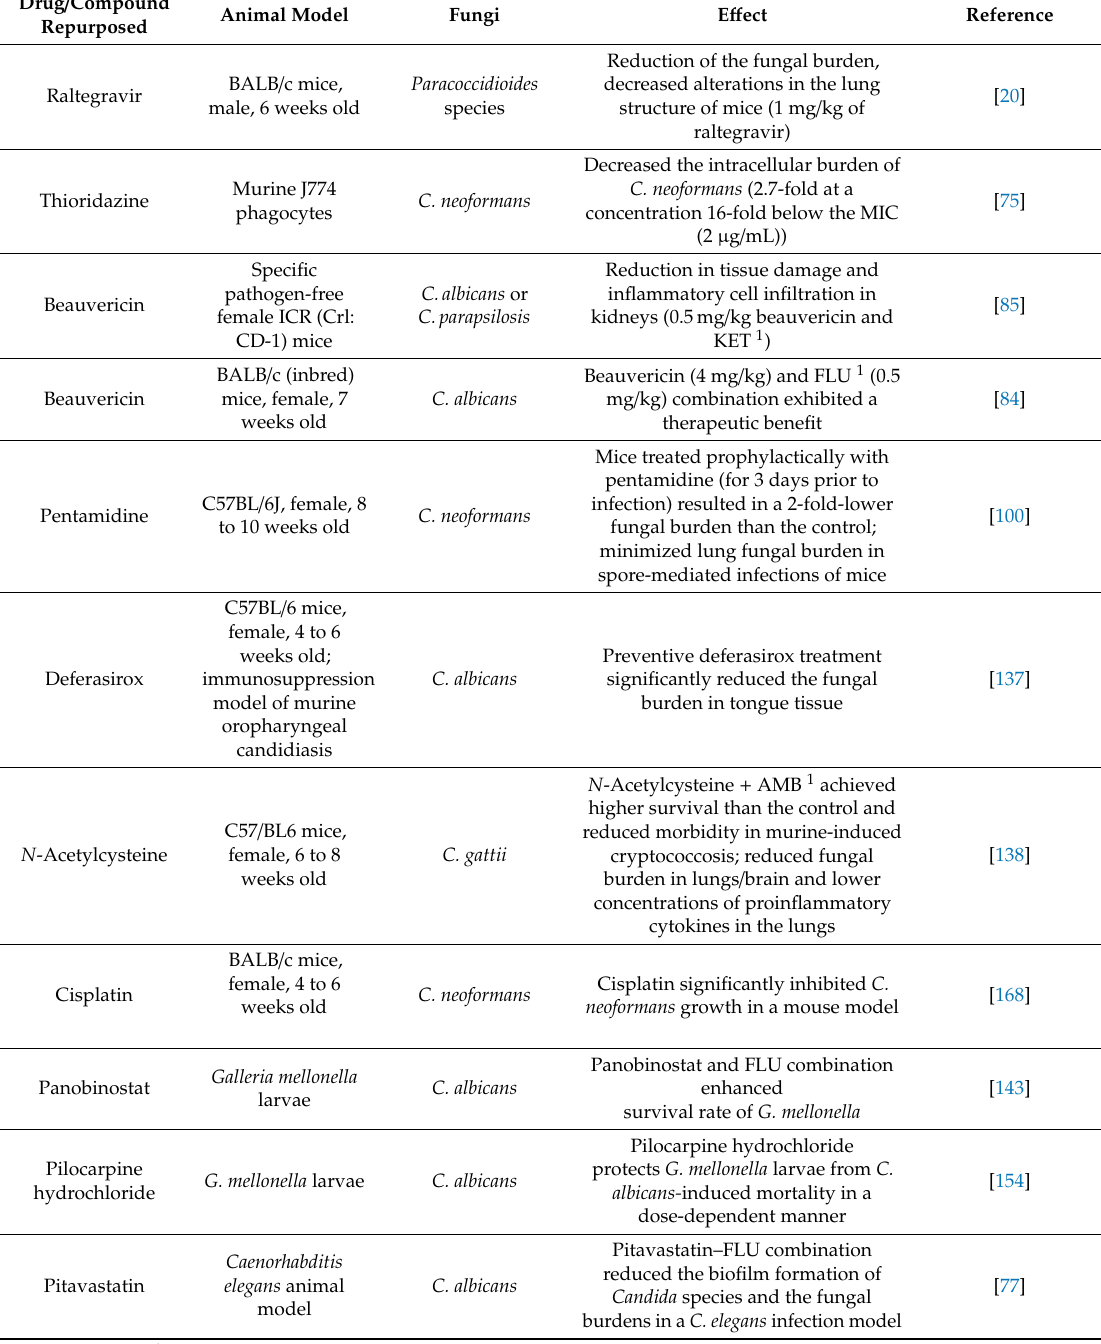
Table 3. Examples of animal models used in drug repurposing (see also Table S1, Supplementary